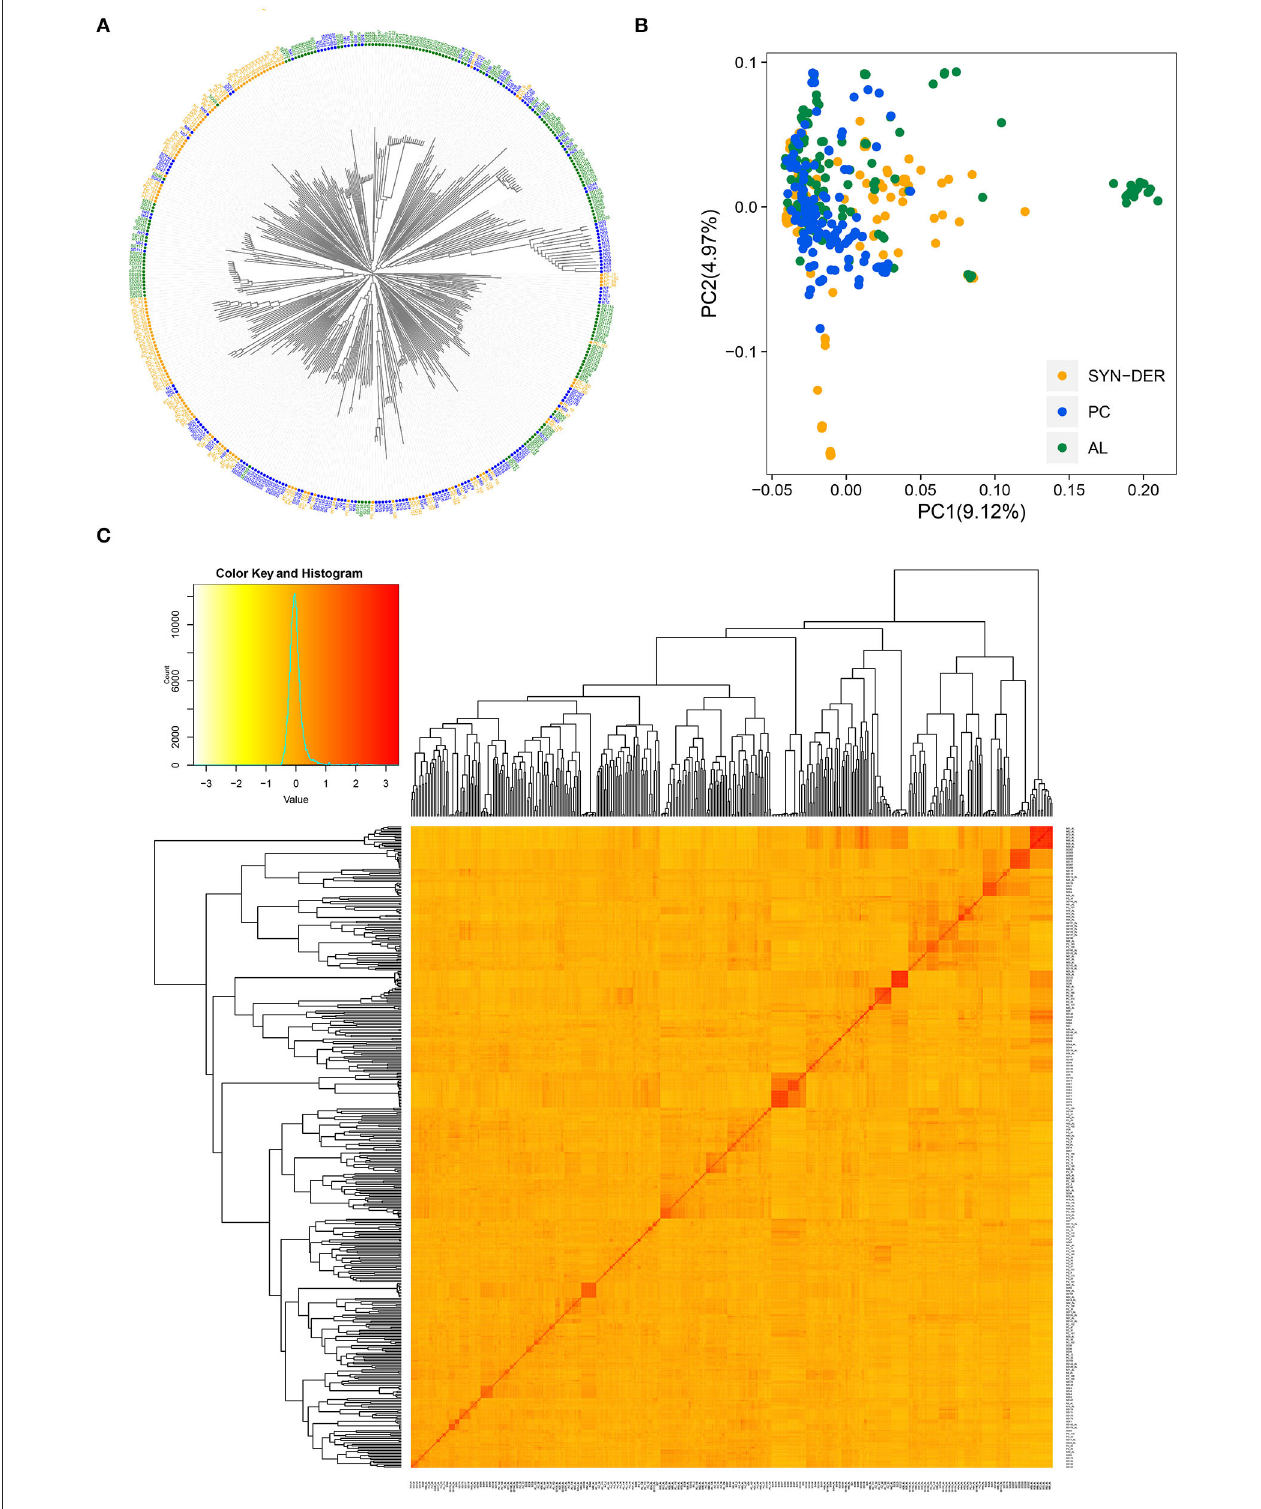
FIGURE 3 | Population structure and diversity analysis of 422 wheat accessions using 18,589 high-quality SNPs. (A) Neighbor-joining (NJ) tree, (B) principal component analysis (PCA) plot, and (C) heat map of pairwise kinship matrix with the tree shown on the top and left. The SYN-DER indicates synthetic-derived wheats; PC, commercially released Pakistan cultivars; AL, advanced breeding lines.